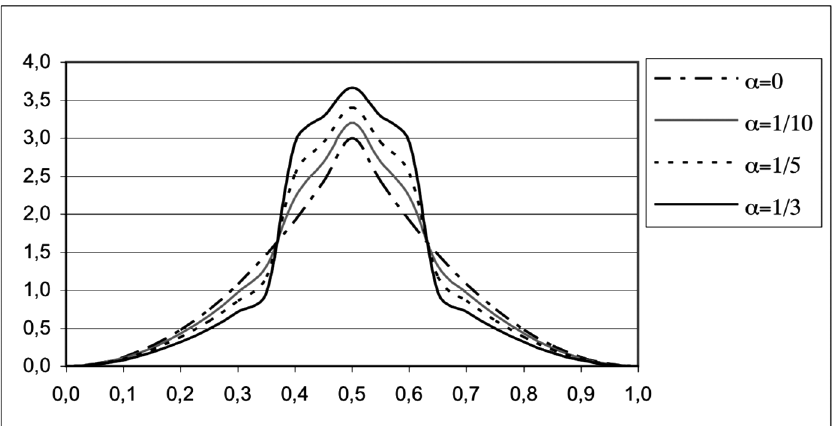
Figure 8 – Symmetric MTSP density ( κ =3 , β =0. 2, α variable).